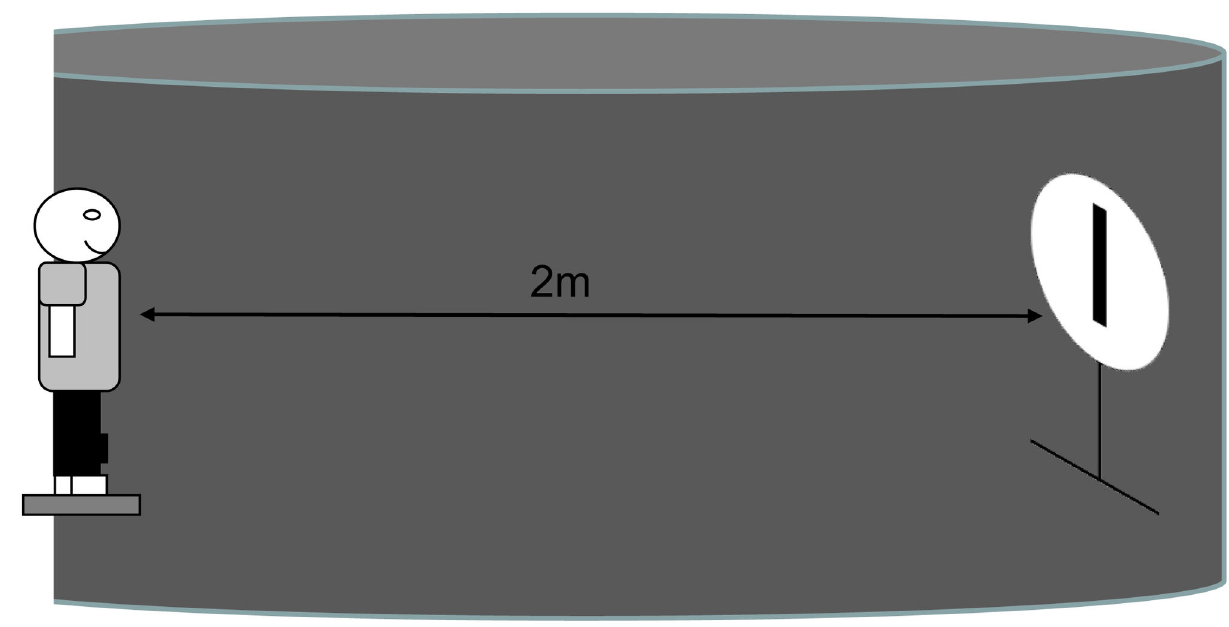
Figure 2. Experimental set-up. The children are on the postural plateform, the visual subjective at 2 meter in front of them, with the black curtain around them in the